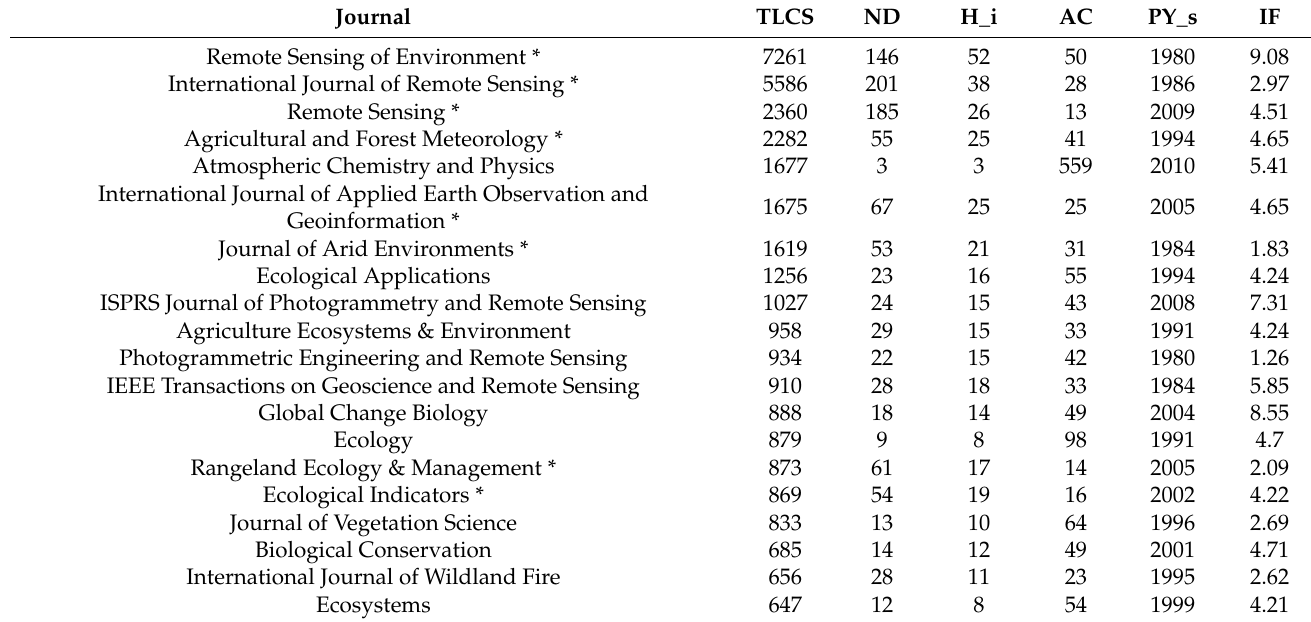
Table 3. Top 20 journals ranked by the total local citation score (TLCS) in GRS research from 1980 to 2020.